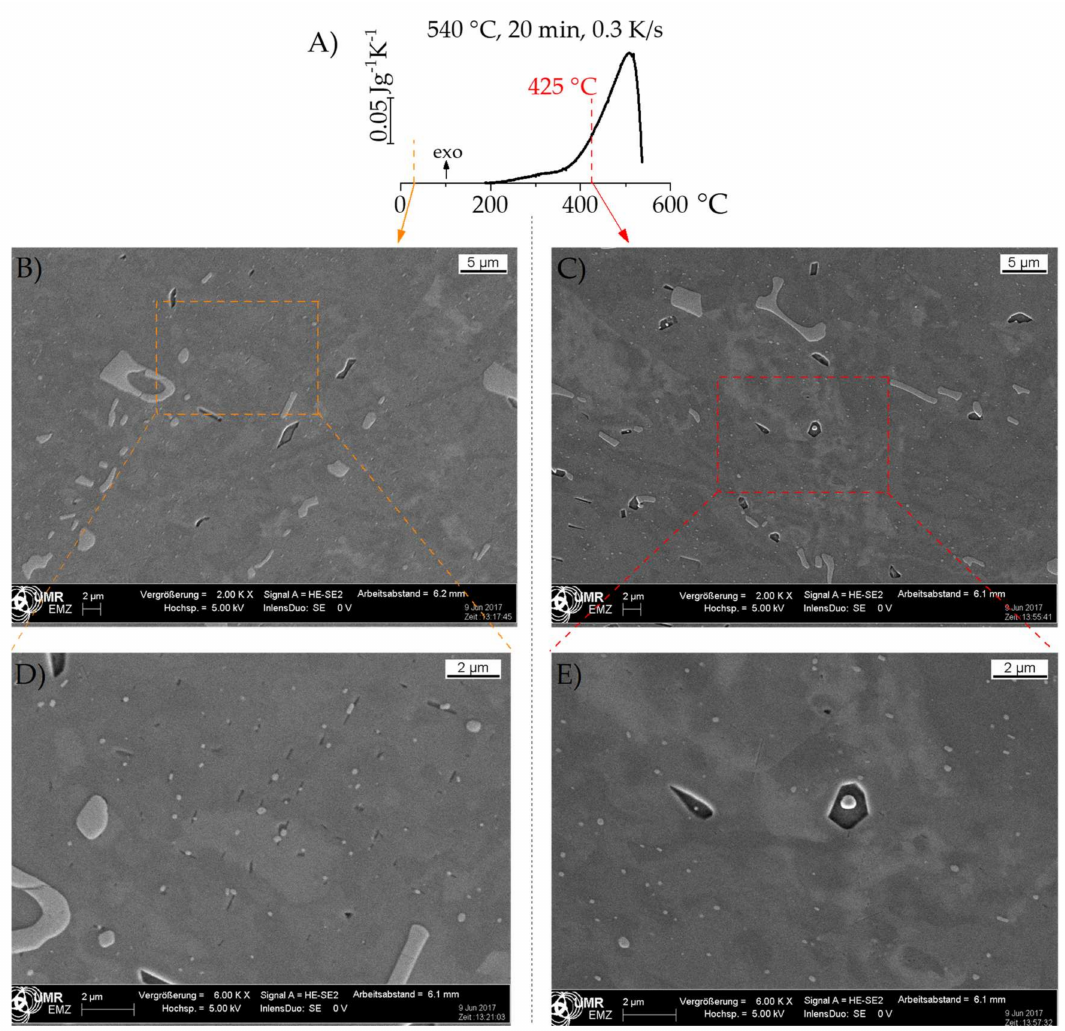
Figure 9. ( A ) DSC cooling curve after solution-annealing at 540 ◦ C, a 20 min soaking time, and a cooling rate of 0.3 K/s, and ( B – E ) associated scanning electron microscopy (SEM) images at different